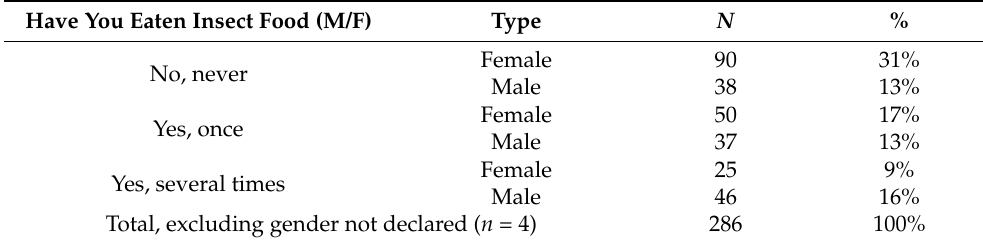
Table 4. Previous experiences with insect food consumption, by gender.